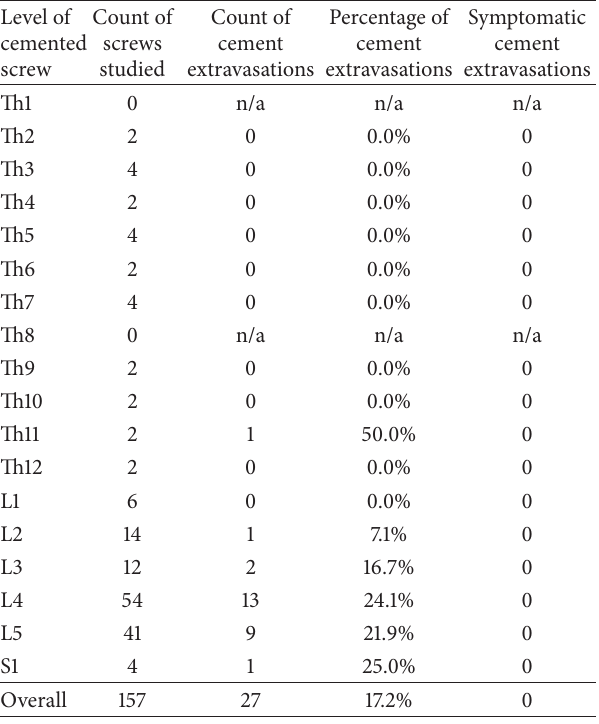
Table 2: Distribution of cement extravasations. The table shows the numbers and frequencies of cement extravasations assigned to the level of minimally invasively cement-augmented pedicle screws. Note that the count of cement extravasations implies the assessment based on plain radiographs and computed tomography together.